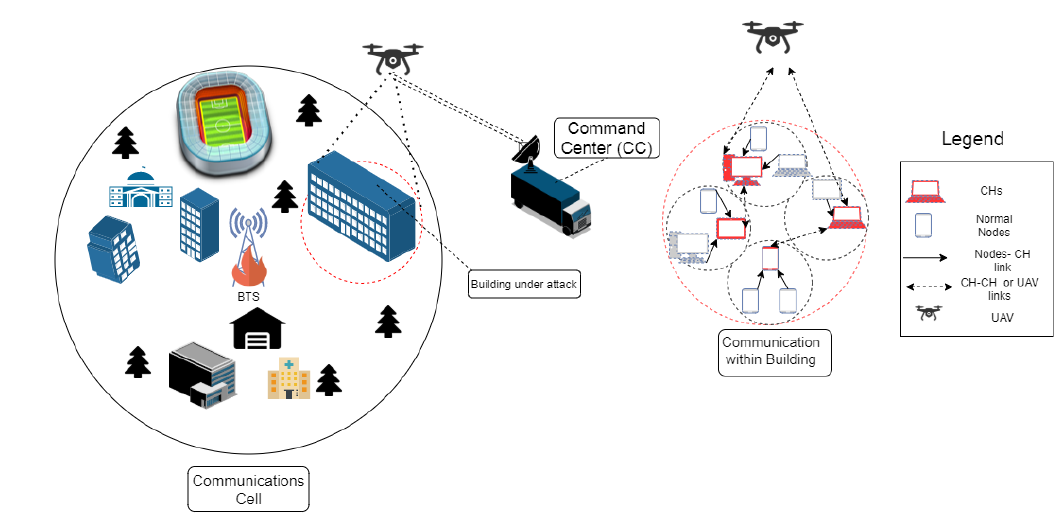
Figure 1. Disaster-affected